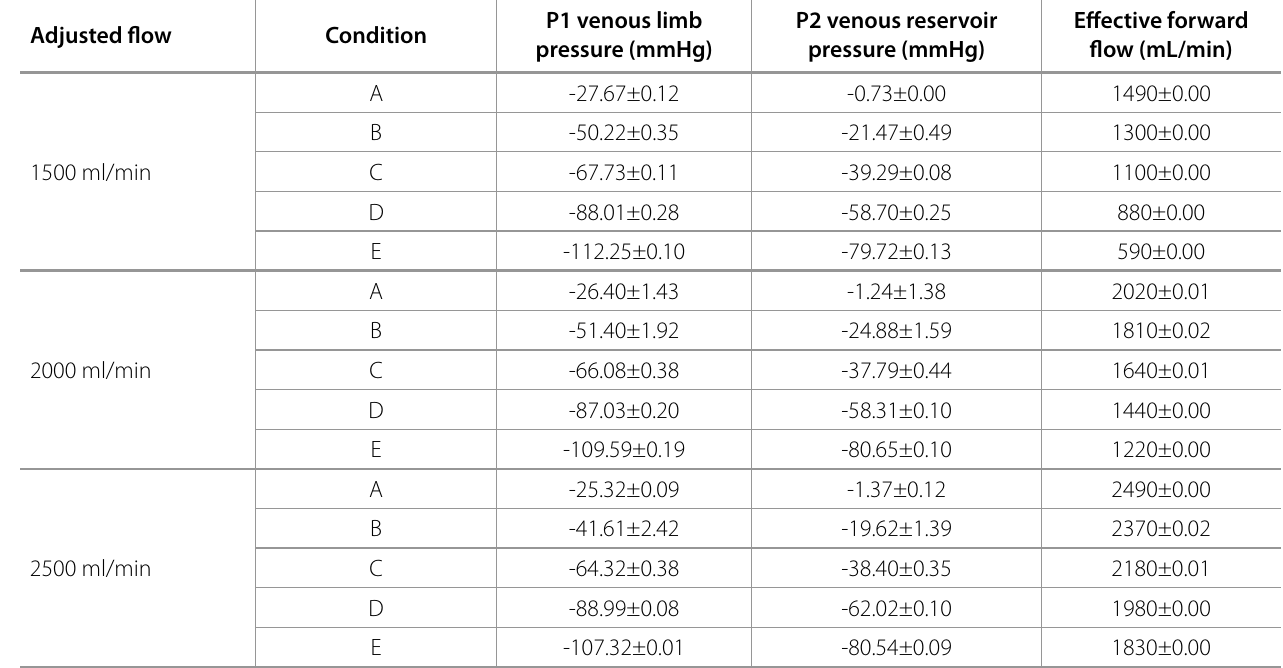
Table 1 . Mean venous limb pressure (P1), mean venous reservoir pressure (P2), and arterial line flow (forward flow) measured at baseline flow of 1500, 2000, and 2500 mL/min with vacuum off and increments of vacuum-assisted venous drainage levels (-20, -40, -60, and -80; conditions A to E) keeping the purge line